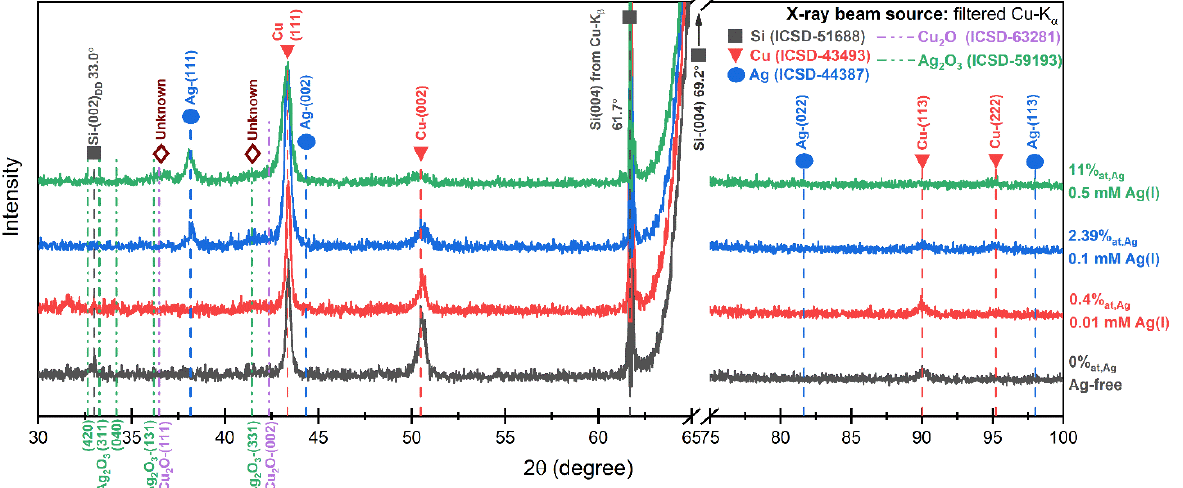
Figure 5. XRD patterns of films with various compositions (deposited at − 0.85 V in the solution 0.5 M H 2 SO 4 + 10 mM CuSO 4 with various concentration of AgNO 3 ).